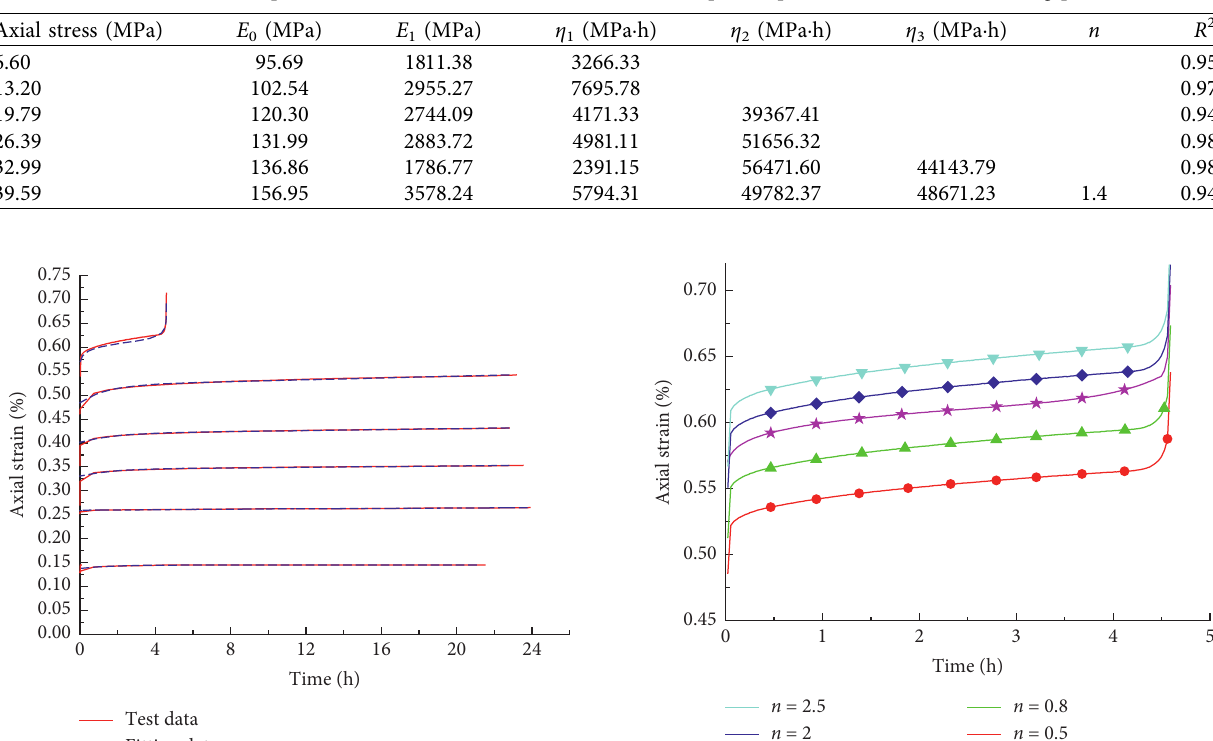
n = 2.5 n = 2 Figure 15: Sensitivity analysis of creep equation parameter n .